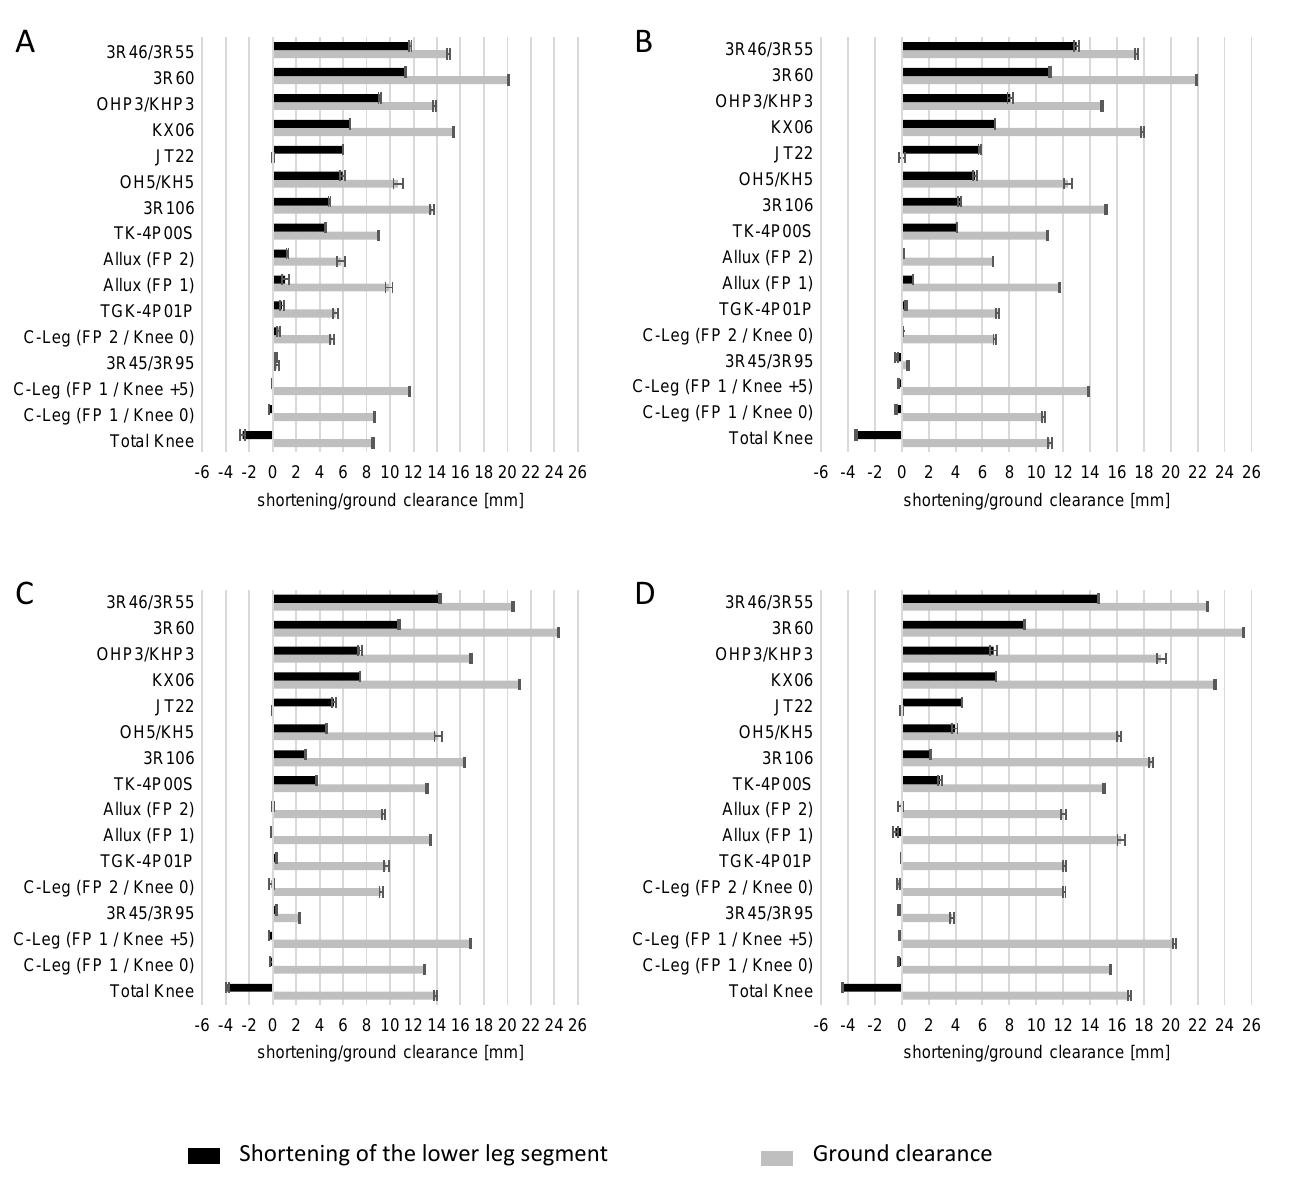
Figure 4: Shortening of the lower leg segment (black) and ground clearance (grey) at the instance of minimal ground clearance (A) 15°, (B) 20°, (C) 25° and (D) 30° hip flexion; mean with standard